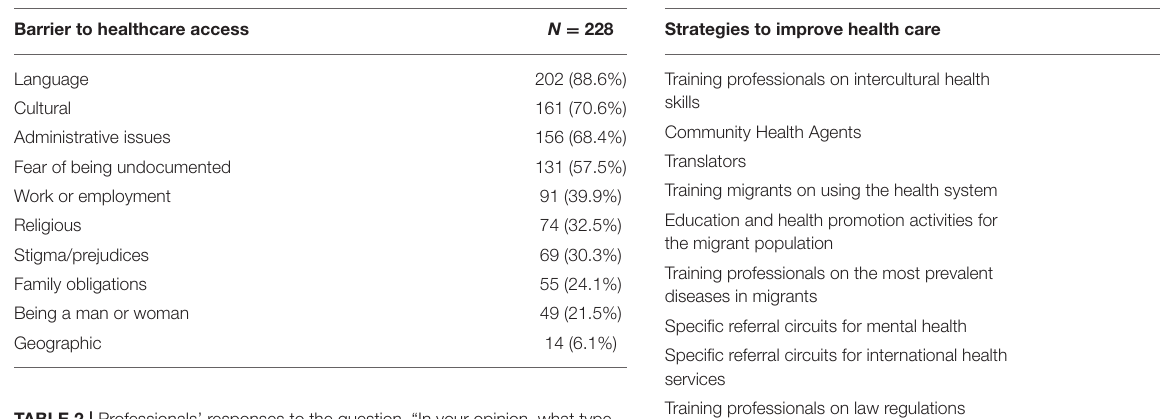
TABLE 3 | Professionals’ responses to the question, “What tools/strategies do you think could improve care for migrants, refugees, and asylum seekers in your